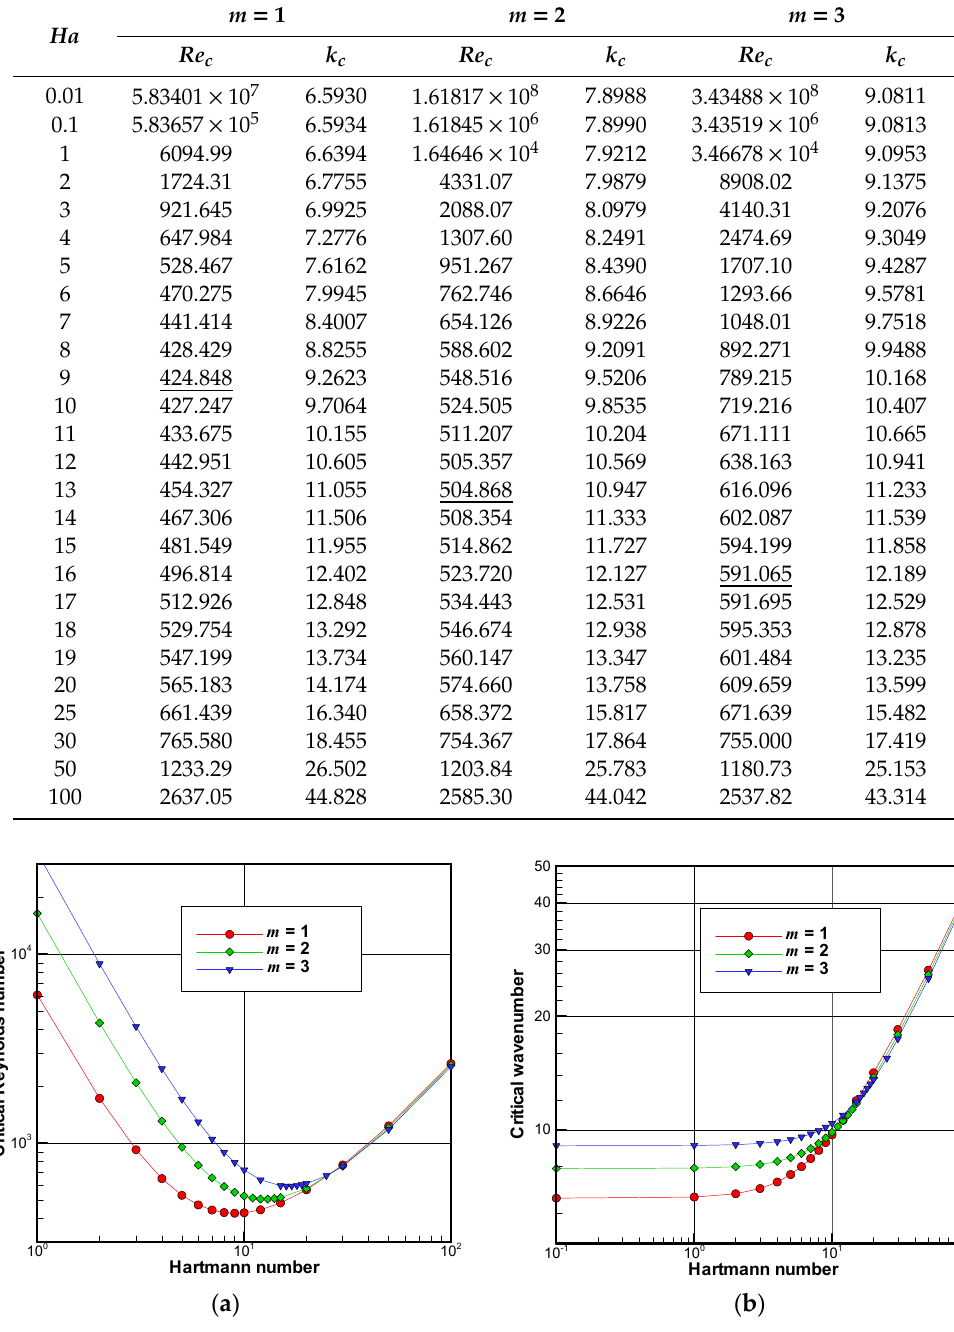
Figure 6. The critical Reynolds numbers and their corresponding axial wavenumbers as a function of the Hartmann number for the three cases of magnetic pole-pairs. ( a ) Critical Reynolds number; ( b ) critical wavenumber.